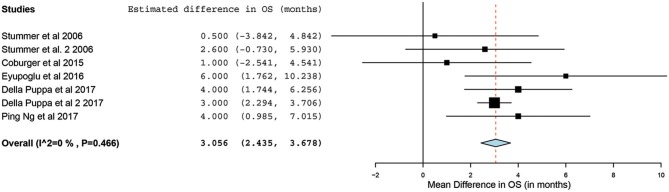
Forest plot graph representing the meta-analysis of mean difference in overall survival (95% confidence interval [CI]) among patients with primary high-grade glioma treated using 5-aminolevulinic acid–guided surgical resection vs. conventional microsurgical resection. Used with permission from Barrow Neurological Institute, Phoenix, Arizona.